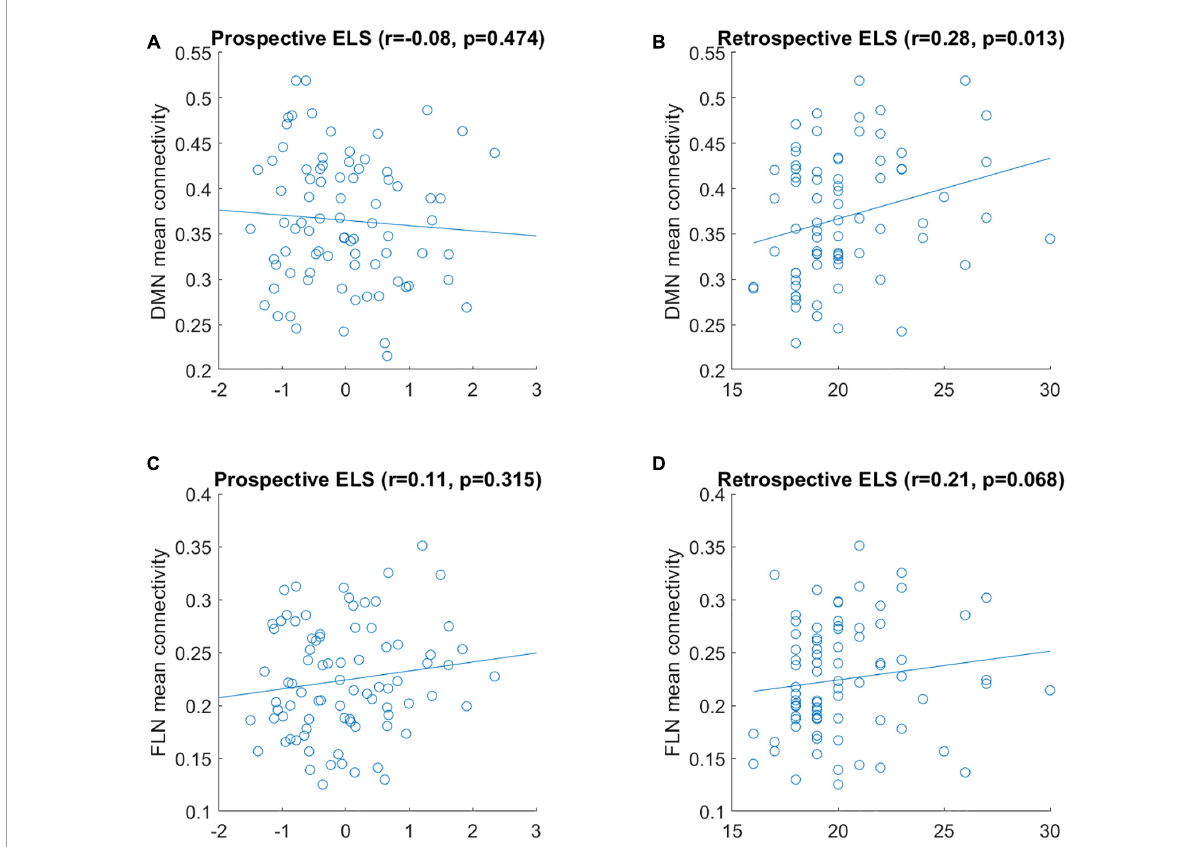
FIGURE1 Correlation between mean connectivity of DMN (A,B) and FLN (C,D) and prospective ELS (A,C) and retrospective ELS (B,D) variables. y -axis represents the mean correlation strength between the nodes of the network and x -axis represents the scores obtained from the ELS measure.